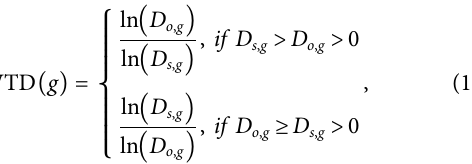
Frontiers in Earth Science |